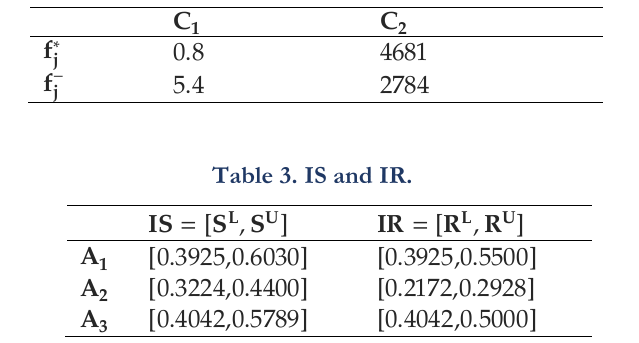
Table 2. PIS and NIS.